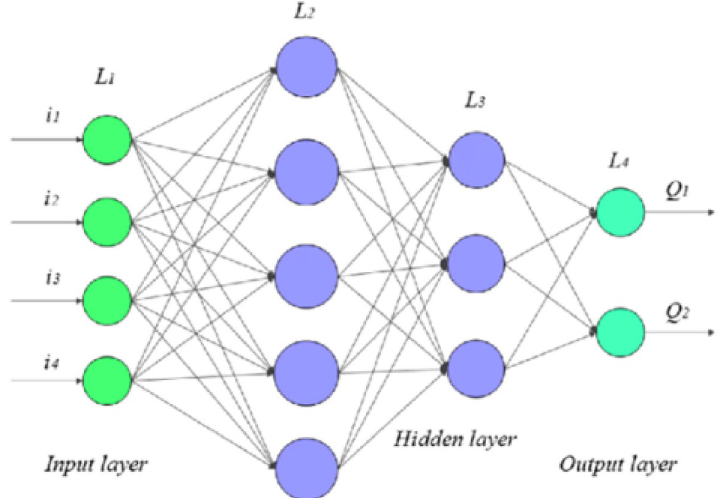
Fig. 4 Structure of Pseudo-Predictive deep denoising network